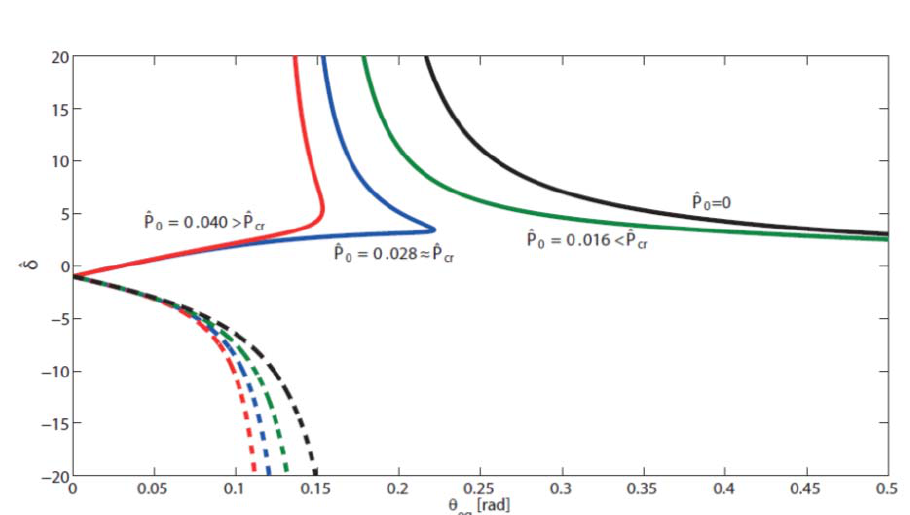
 for different values of the eq